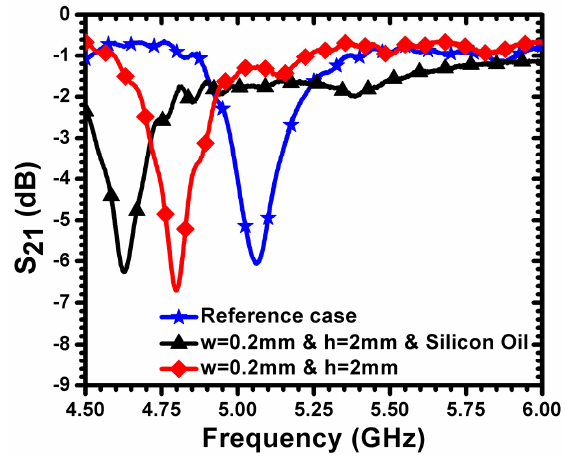
Figure 10. Minimum transmission of the sensor for a crack width of 200 µ m and a depth of 2 mm for the reference case (without a crack) and for the cases of a crack with and without silicon